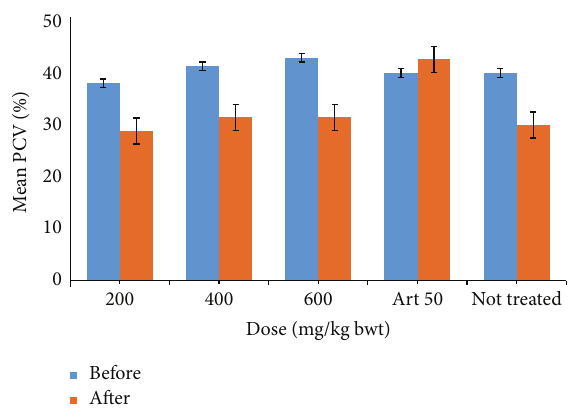
Figure 4: Effect of crude ethanol extract of P. guineense leaf on the pack cell volume (PCV) of P. berghei -infected mice.